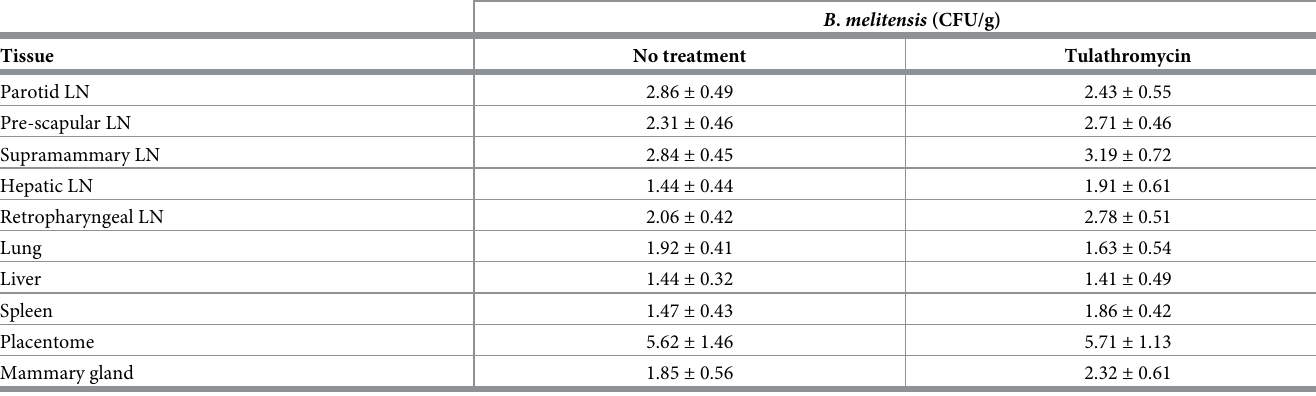
Table 4. B . melitensis tissue colonization and bacterial